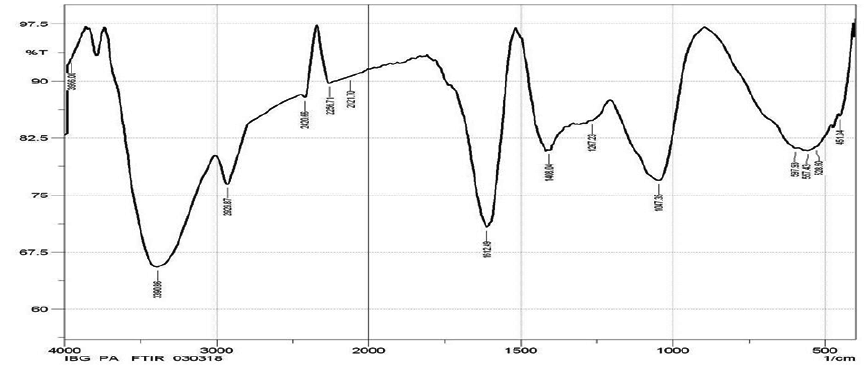
Fig. 1.1. FT-IR Analysis of Mentha piperita crude extract